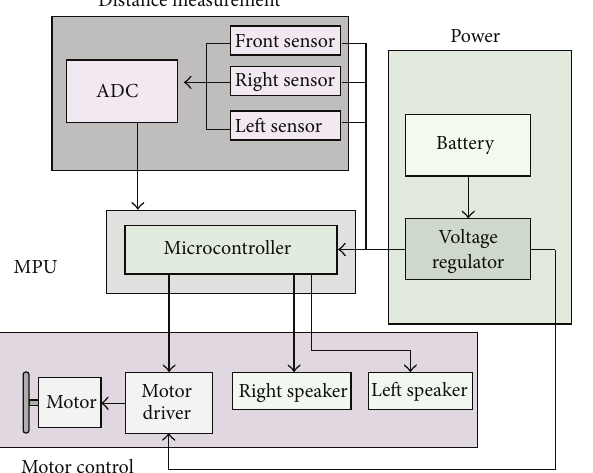
Figure 2: Block diagram of the system.